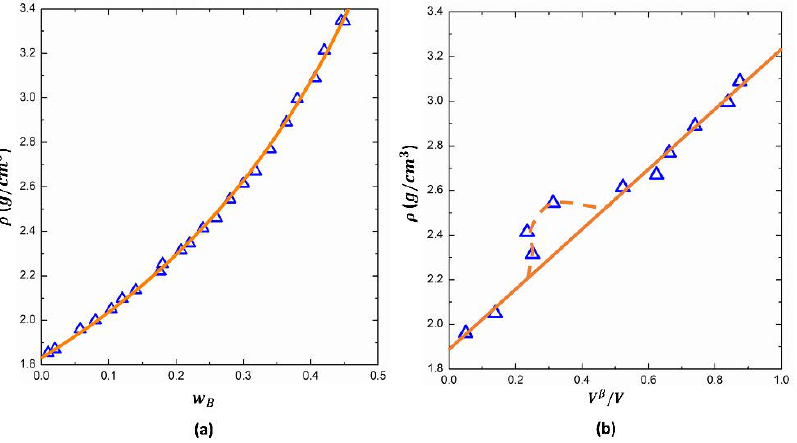
Figure 11. Variation of density with ( a ) weight fraction of PbO w B and ( b ) volume fraction of PbO rich phase V β / V in PbO-B 2 O 3 glass system. Data points in blue triangles and fitting lines in orange. (Recreated with data from [130] and [134].)